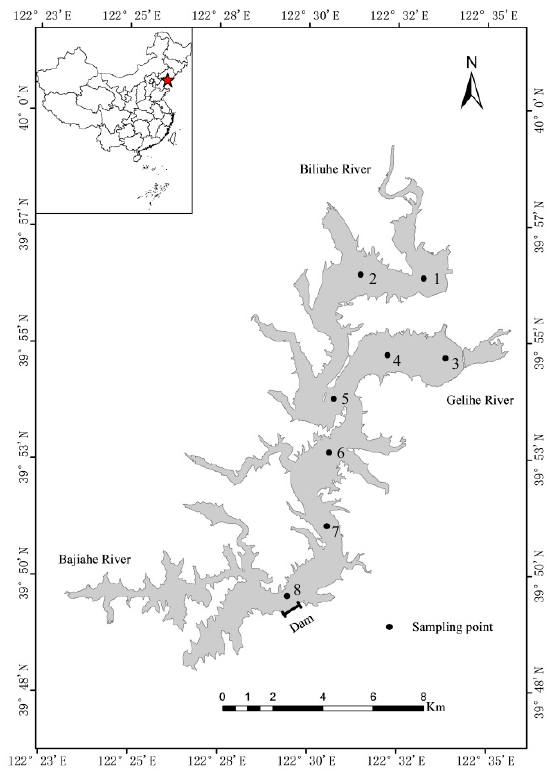
Figure 1. Location of the study area and sampling points.